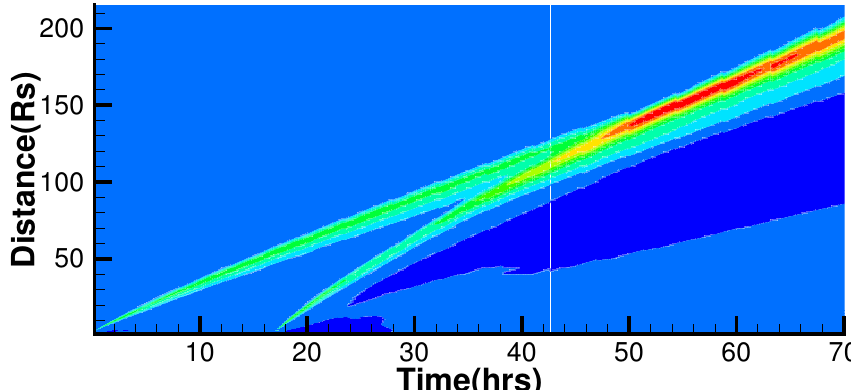
Figure 7. The height/time map of the relative density distribution obtained along the Sun–Earth direction during 0–70 h expressed in solar radii from 1 to 215 R s for CME23.